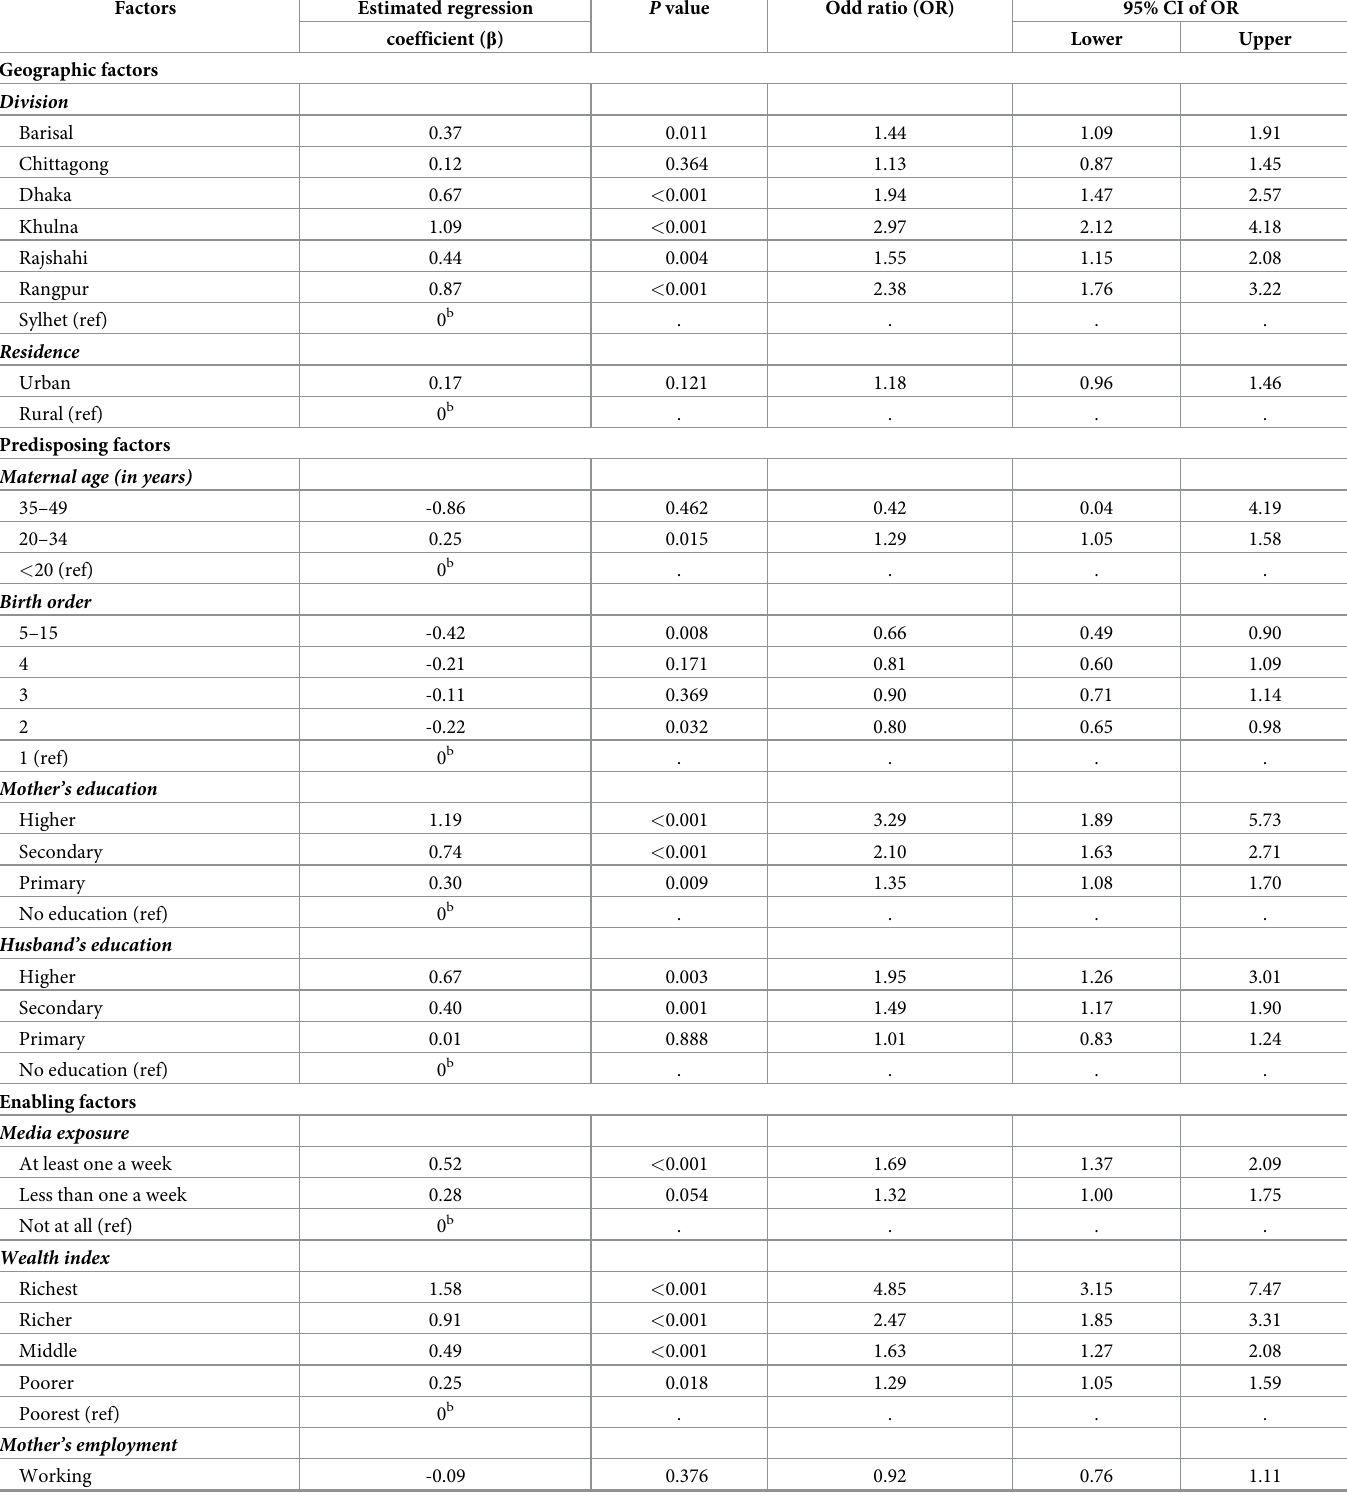
Table 2. Results of binary logistic regression analysis to identify the determinants of ANC contacts (N =